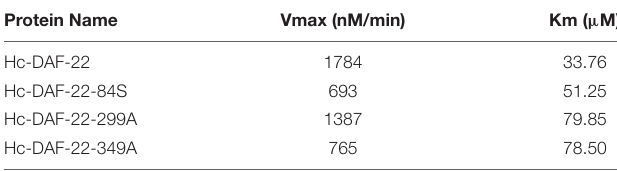
TABLE 2 | Vmax and Km values of each